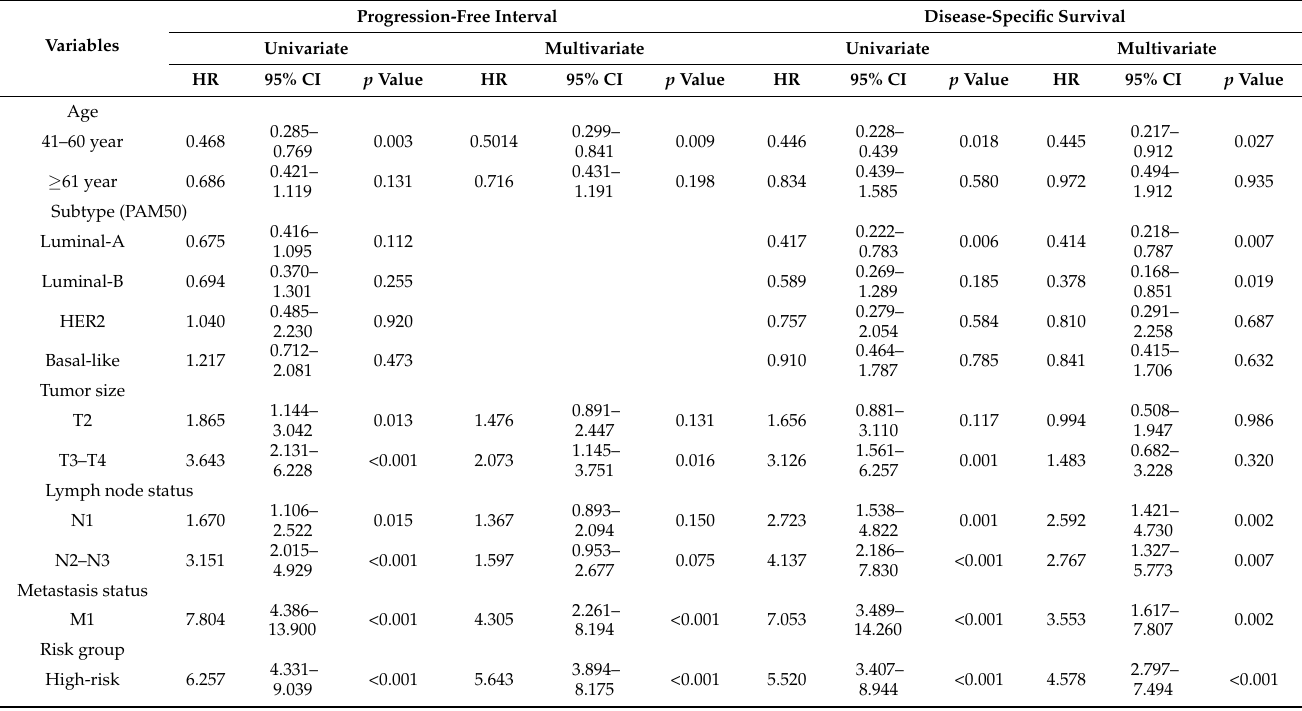
Table 2. Univariate and Multivariate Cox proportional hazard models of PFI and DSS in Breast